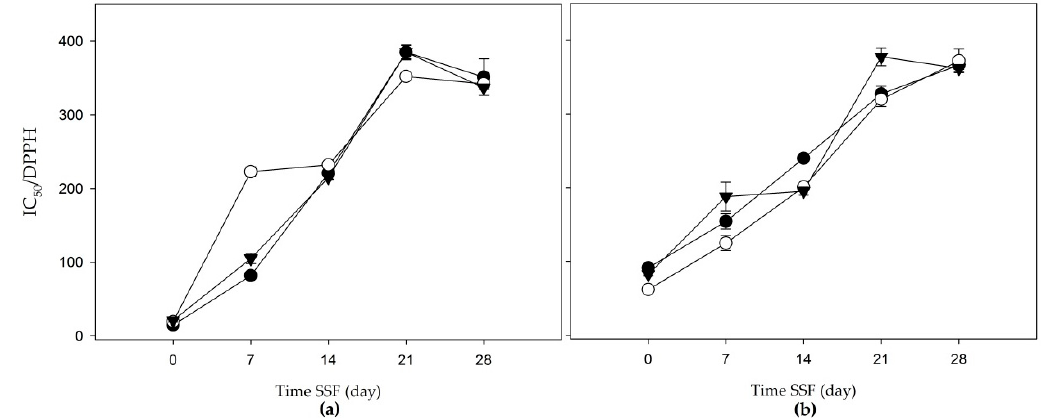
Figure 1. Total phenolic compounds (mg gallic acid equivalent per g substrate on dry weight (mg GAE/g substrate dw)) of the solid-state fermentation of agroindustrial residues: ( a ) Apple bagasse; ( b ) Agave mezcalero bagasse. Acetone and water (80:20 v/v ( )); methanol extract ( ); aqueous extract ( ). Time SSF = time solid-state fermentation. Values are the mean ± standard ). Time SSF = deviation.